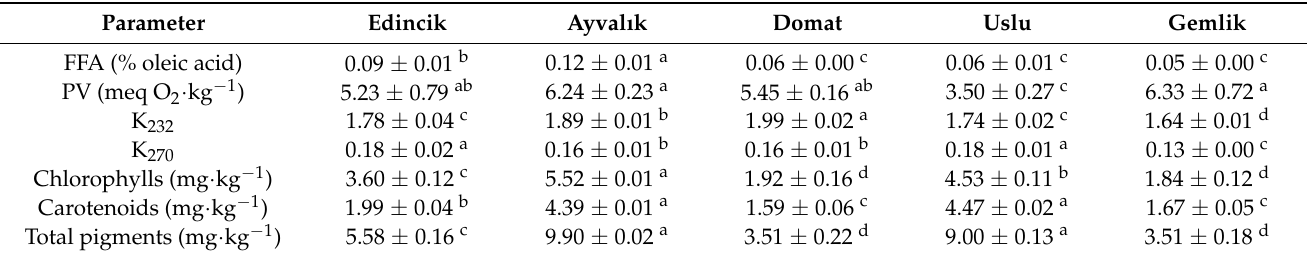
Table 1. Legal quality parameters and pigment contents of EVOOs from five Turkish olive